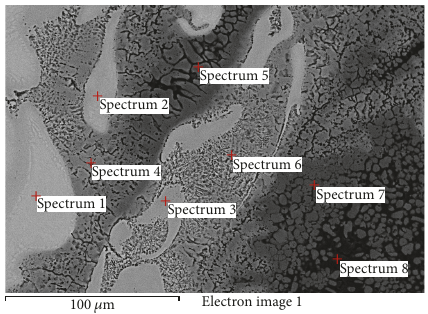
Figure 21: Location of point EDX analysis carried out in different zones of weld